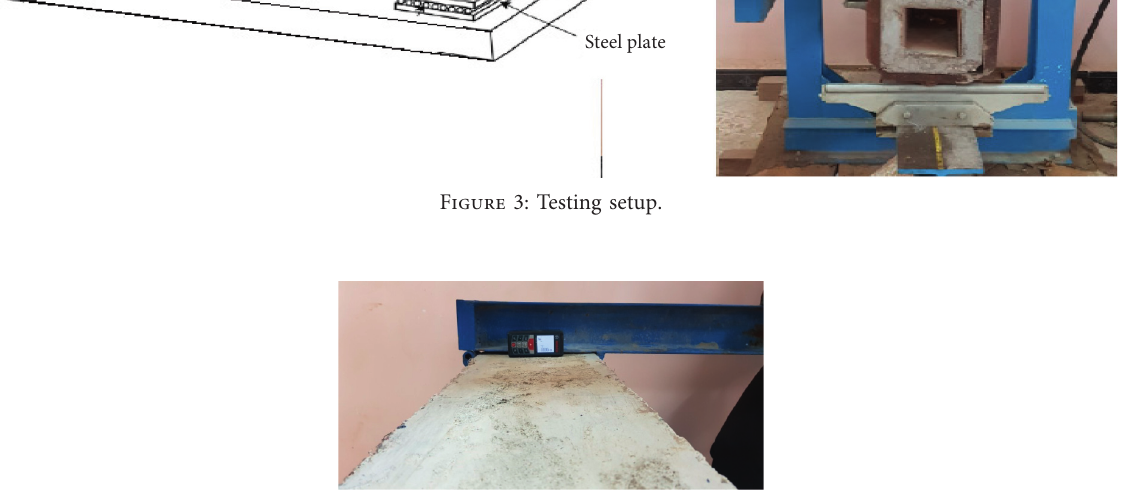
Figure 4: Twist angle